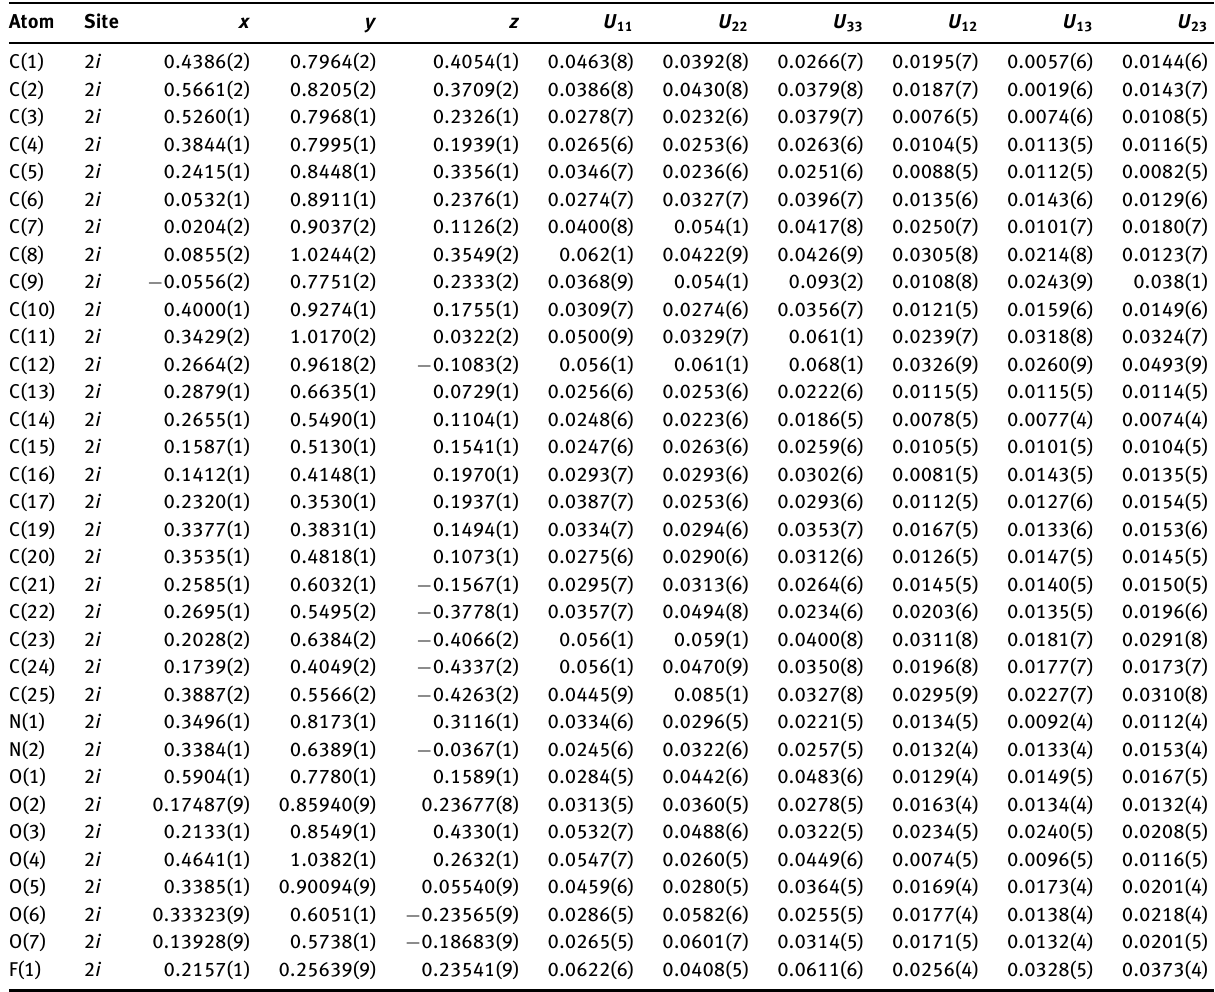
Table 3: Fractional coordinates and atomic displacement parameters (Å 2